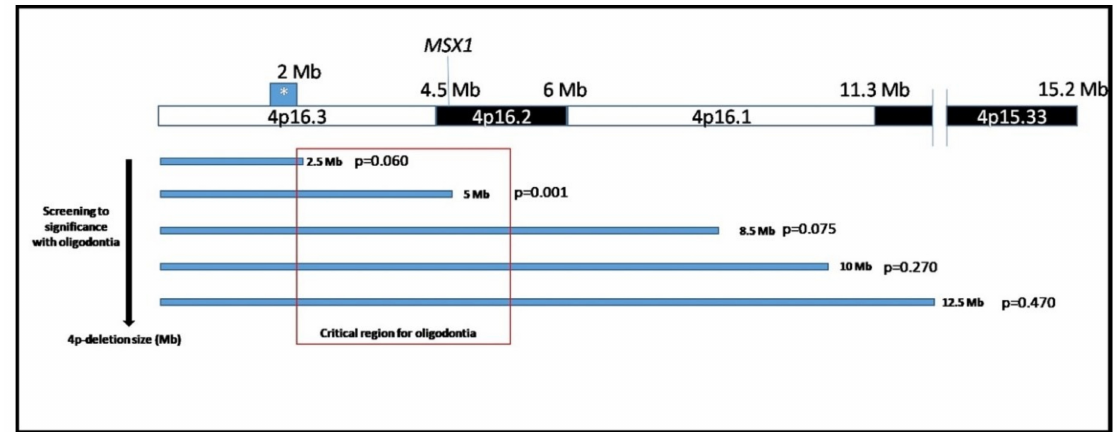
Figure 4. p -arm of chromosome-4 screening in Wolf-Hirschhorn syndrome patients with oligodontia. Open square red area is minimal region associated with oligodontia in our cohort (2.3–5.5 Mb). Remarkably, MSX1 gene is placed at 4.85 Mb from